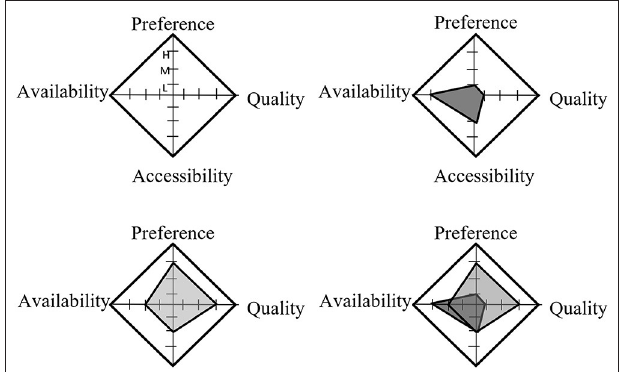
FIGURE 2 | Diagrams to display adequacy of the four components of security. Upper left shows the basic idea. H, high; M, medium; L, low ratings for security. Upper right and lower left illustrate two potential configurations (of many). Lower right shows how the assessments in different communities or the same community at different times could be displayed together to make a comparison or to look for typologies (which would presumably emerge with more communities than